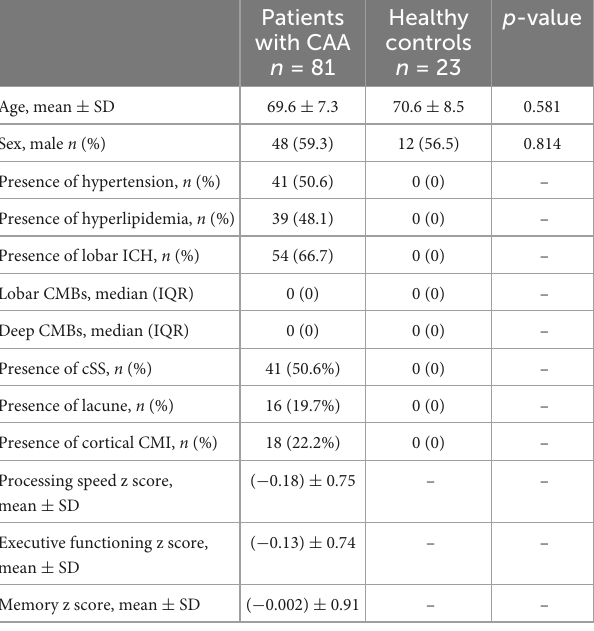
by Lindeman et al. (1980) and implemented in the R package “relaimpo” (version 2.2-3) (Groemping, 2006). pWMH was log-